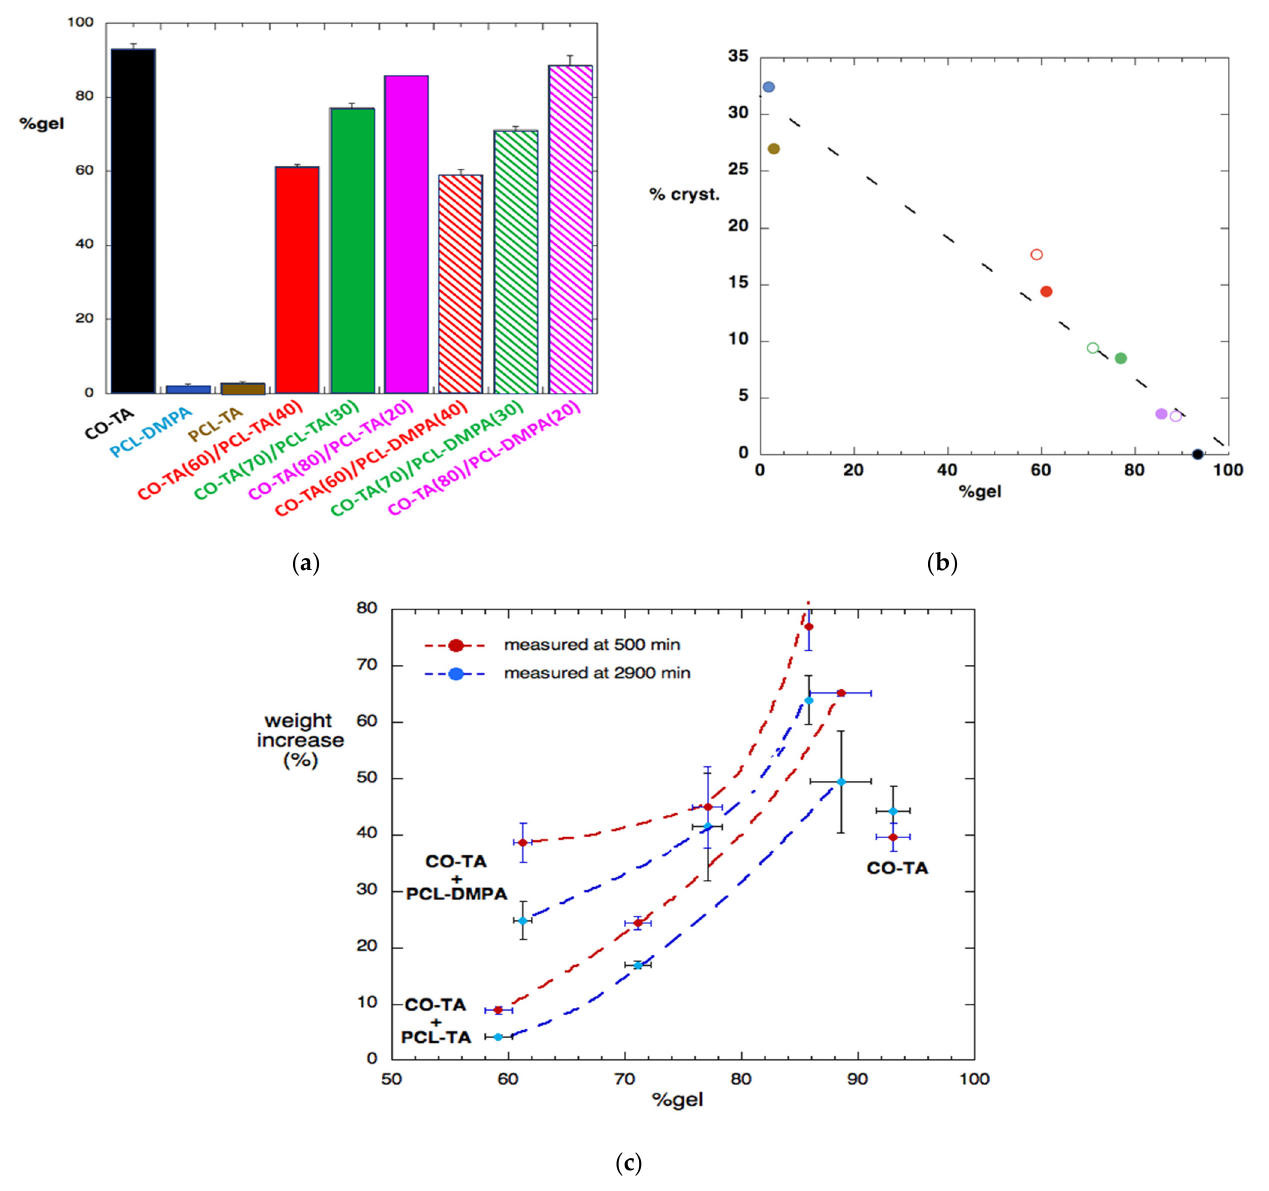
Figure 7. Gel content (%) of the films, extracted with toluene ( a ). Variation of the sample crystallinity with the gel% ( b ). The colors identify the same samples as in ( a ), with filled symbols used for the CO-TA/PCL-TA and open symbols for the CO-TA/PCL-DMPA. Toluene absorption by immersion in the solvent, calculated as % of weight increase ( c ) vs. the gel content of the samples. Lines are drawn merely as guides.